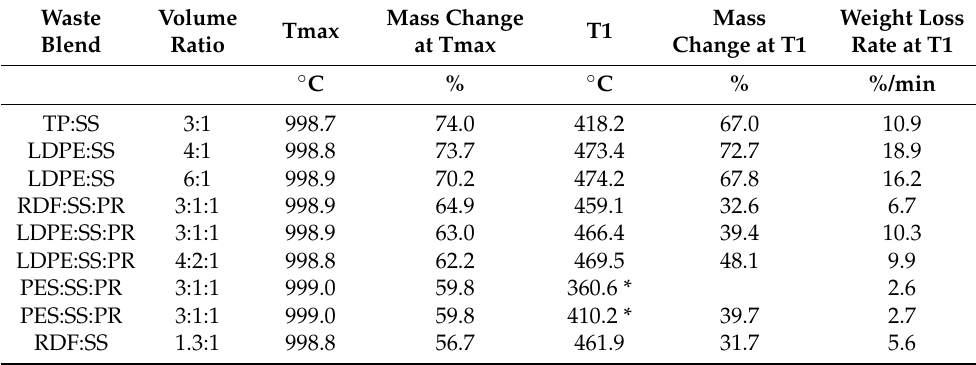
Figure 12. TG/DTG curves of PES:SS:PR and RDF:SS:PR in the same volume ratio.